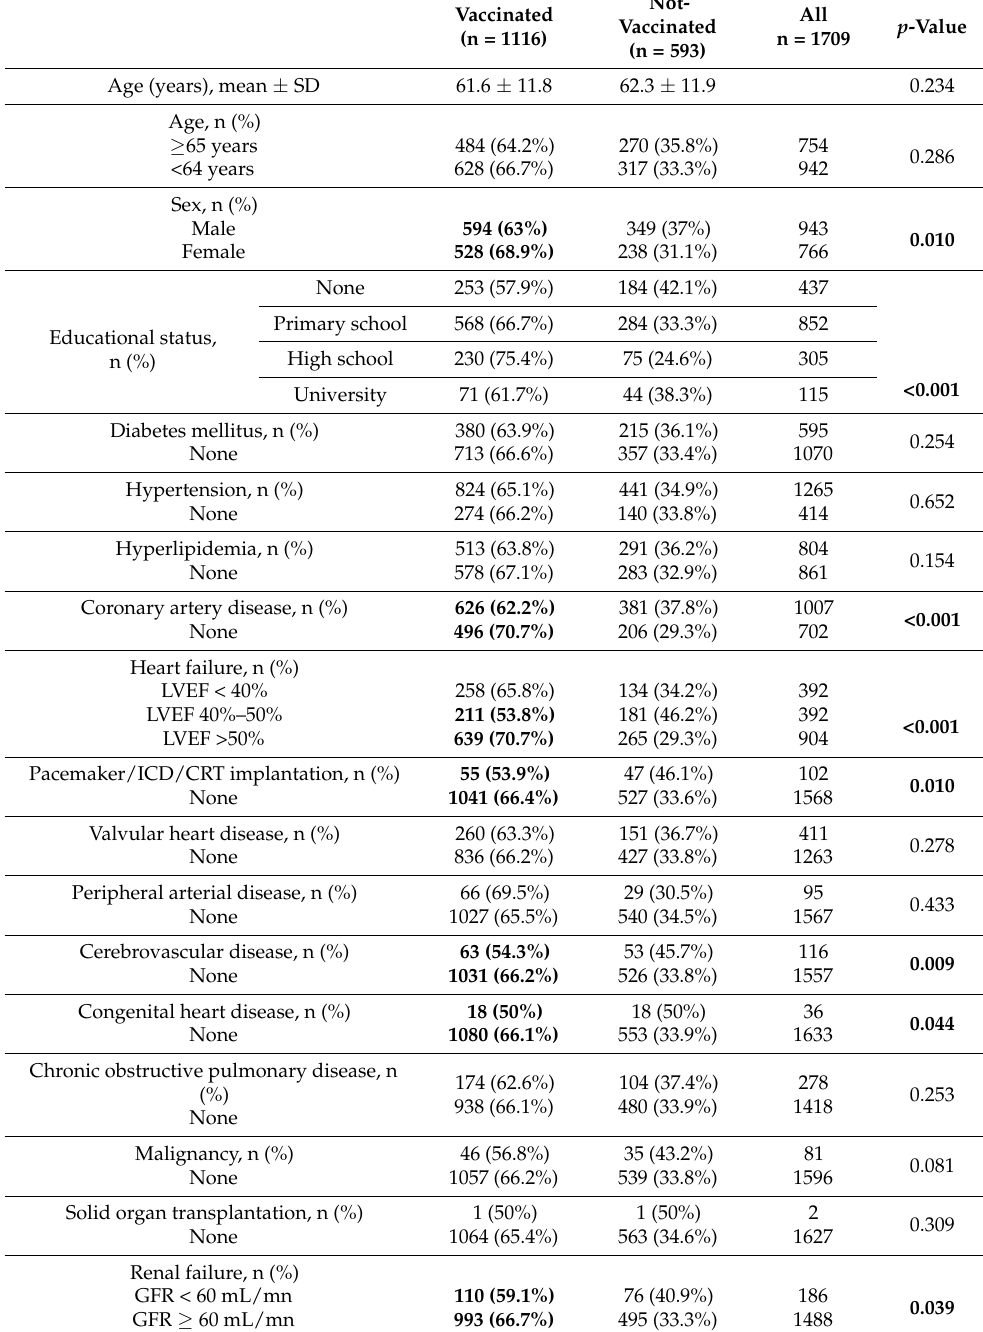
Table 3. Comparison of demographic and clinical characteristics between vaccinated and unvacci- nated patients after being informed about the pneumonia